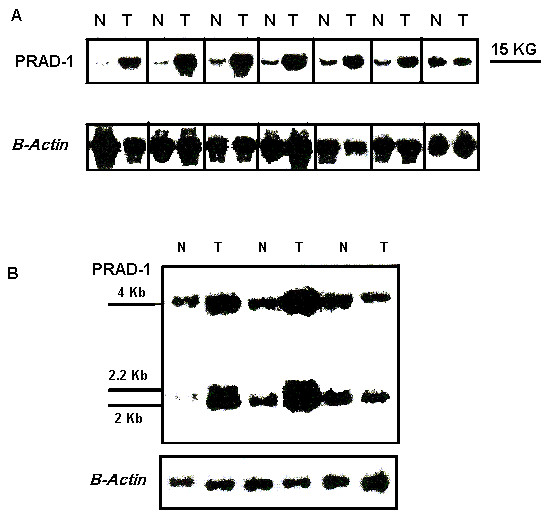
A: Southern blot analysis of normal mucosa (N) and their seven corresponding cases of colonic adenocarcinomas (T1–T7), cases No. 1, 2, 4, and 5 are poorly differentiated whereas cases No. 3, 6, and 7 are moderately differentiated. Genomic DNA was digested with BglII, fractionated by electrophoresis in agarose gel, transferred onto membranes and hybridized with PRAD1 and β-actin. Tumors number 1–6 (Lanes 1–6) show different degrees of PRAD1/cyclin D1 amplification, tumor number 7 (lane 7) was not amplified. B: Southern blot analysis of 3 cases of adenocarcinomas (T) and matched normal colonic mucosa (N). Genomic DNA was digested with EcoRI, fractionated by electrophoresis in agarose gel, transferred onto membranes and hybridized with PRAD1 and β-actin probes for loading control. The identification of the 3 tumors is the same as in Fig. 3A with amplification of PRAD1/cyclin D1 in tumors number 4, 5 (Lanes 1, 2) but not 7 (Lane 3).